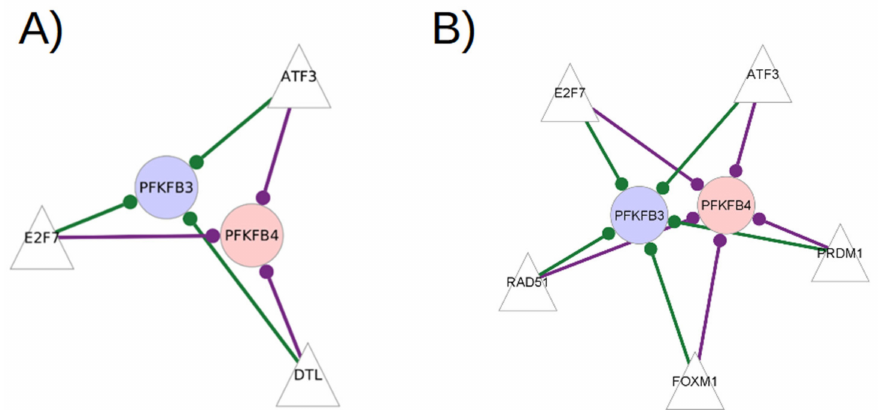
Figure 6. The transcription factors that have edges with both PFKFB3 and PFKFB4 in the RA CD8 + Tem cell GTRD and GeneHancer-annotated networks of differentially co-expressed edges. ( A ) The subgraph from the GTRD-annotated network ( B ) The subgraph from the GeneHancer-annotated network. Triangles indicate transcription factors and circles indicate target genes. Node colour shows the direction of differential expression: red nodes are over-expressed and blue nodes are under- expressed. The presence of an edge between a TF and a target gene refers to a significant difference in the edge weights of that gene pair between untreated RA samples and healthy samples. Purple edges show higher edge weight in RA, and green shows higher edge weight in healthy samples.